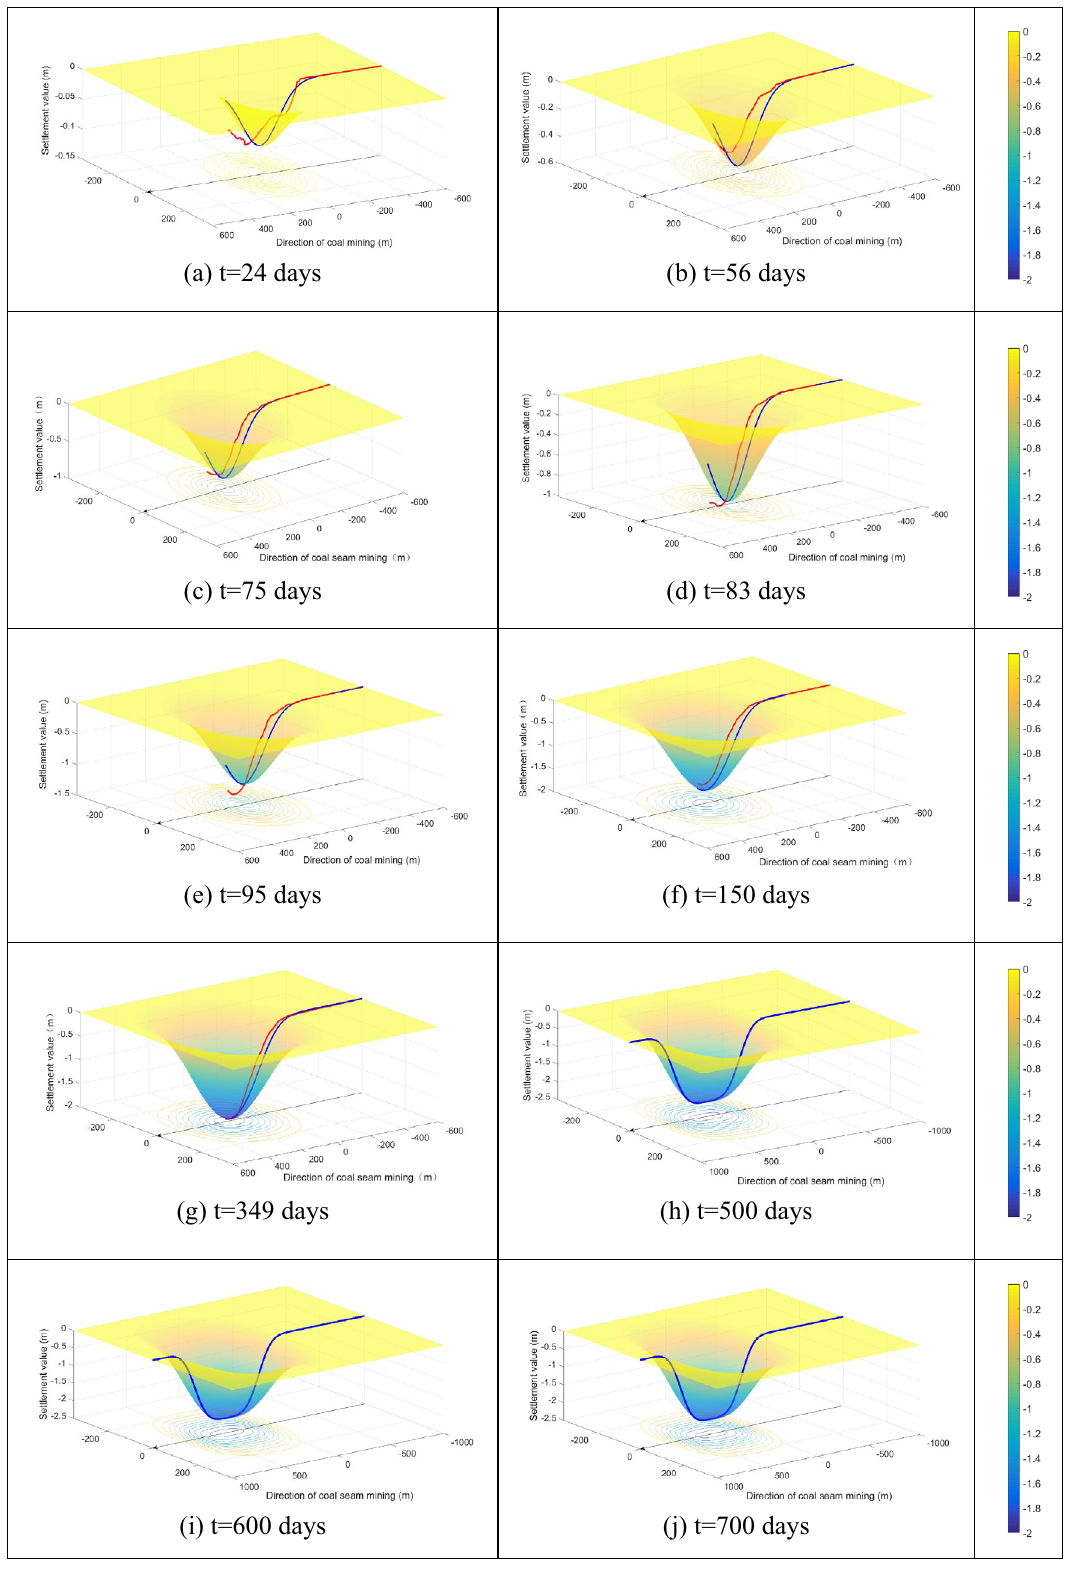
Figure 8. The subsidence basin at different moments ( a – j ) represent the subsidence basin at different time, the red and blue lines represent the monitoring data and prediction value of subsidence,